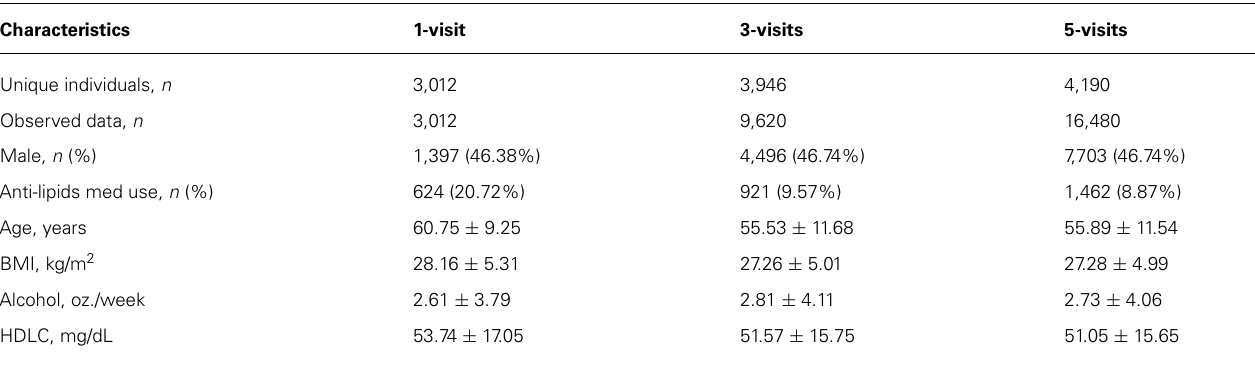
Table 1 | Descriptive statistics of the longitudinal family data used in the analysis.